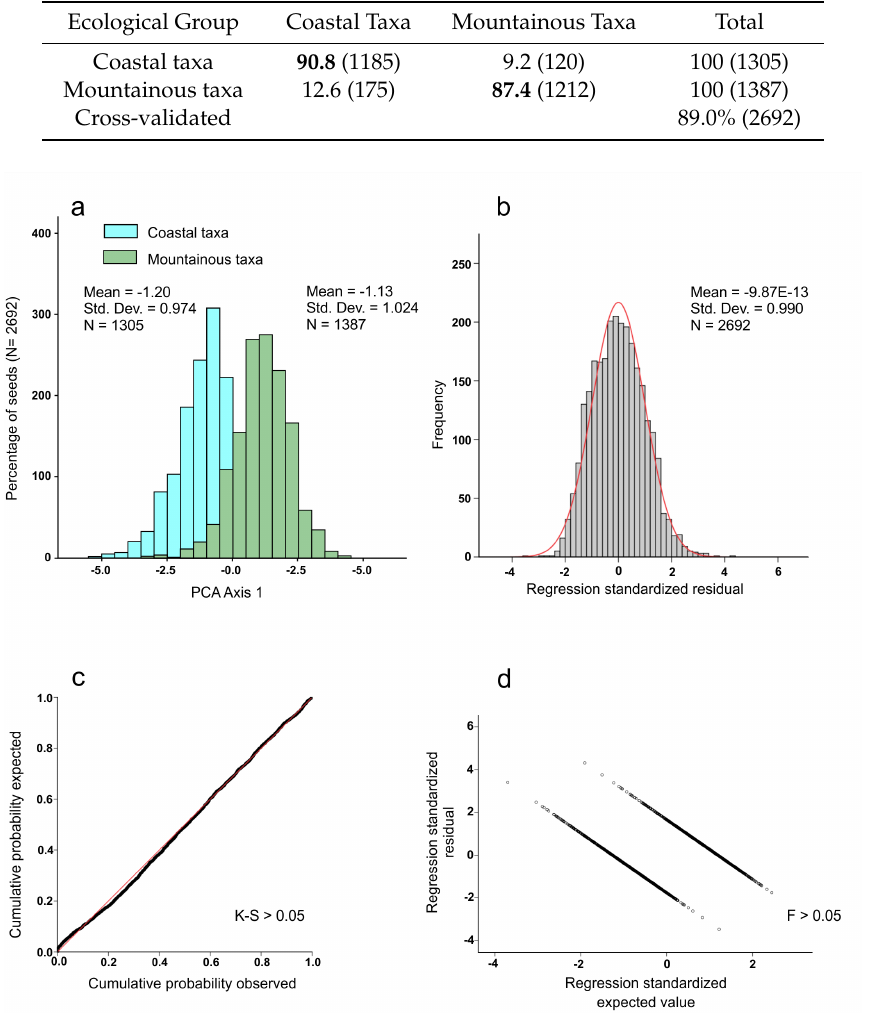
Table 1. Percentages of correct classification among coastal and mountainous Anchusa species endemic to Sardinia. In bold, the correct classification; in parentheses, the number of analyzed seeds.